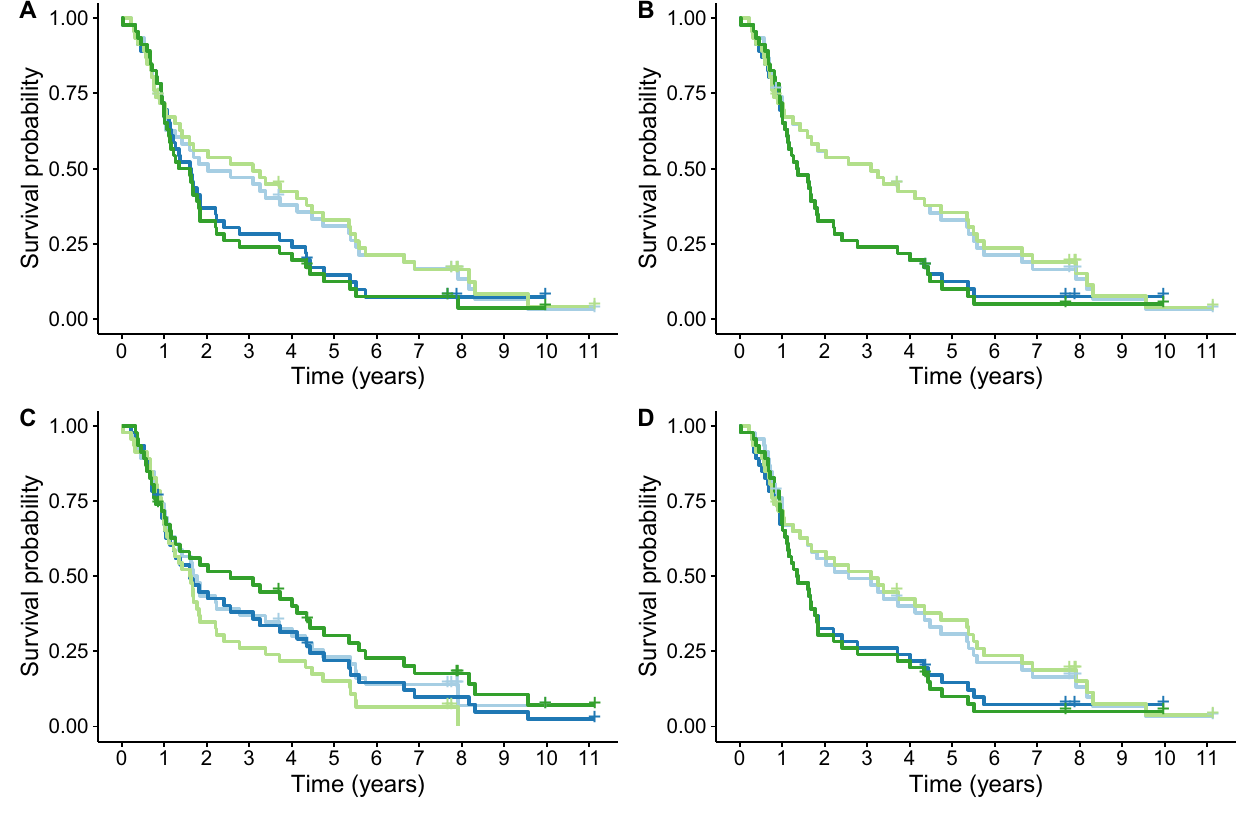
Figure 5. Kaplan Meier survival curves. Overall survival curves for MAASTRO and PMCC contours from the ‘NSCLC-Radiomics’ dataset are given for four radiomics features found to be prognostic in a previously published model, showing similar separation of curves for three features (A, B and D), while feature C shows separation of curves for the MAASTRO contour, however not for the PMCC contour (A = original_firstorder_ Energy, B = original_glrlm_GrayLevelNonUniformity, C = original_shape_Compactness2, D = wavelet-HLH_